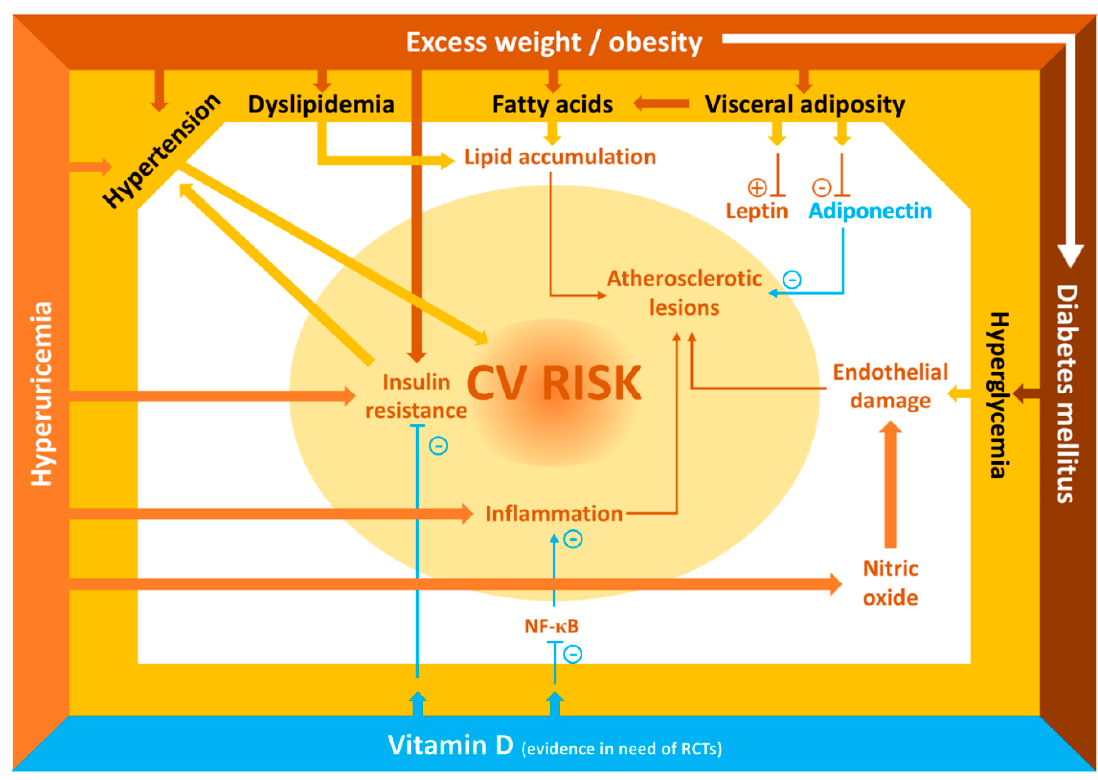
Figure 1. Main cardiovascular risk factors in childhood. Abbreviations: CV, cardiovascular; NF- κ B, nuclear factor κ B, RCTs, randomized controlled trials.